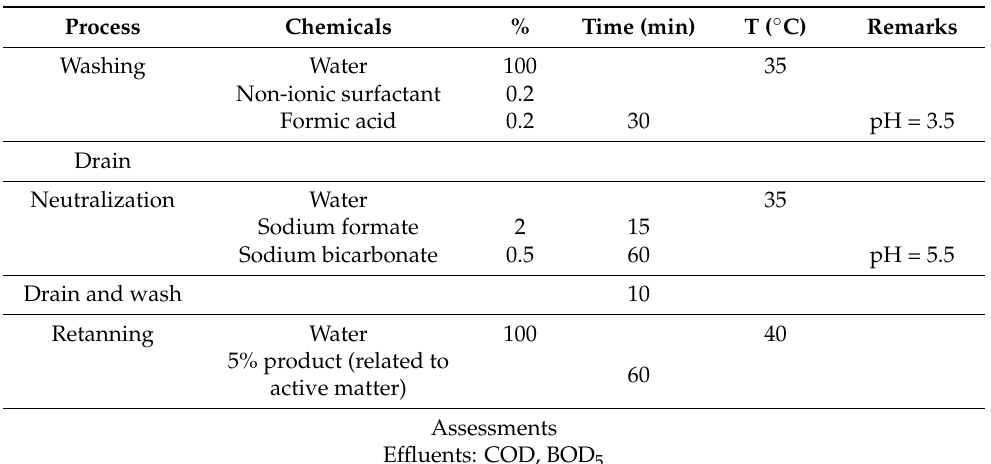
Table 2. Standard application